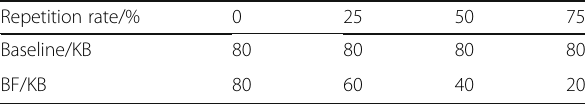
Table 9 Space overhead of cryptographic convergence secret